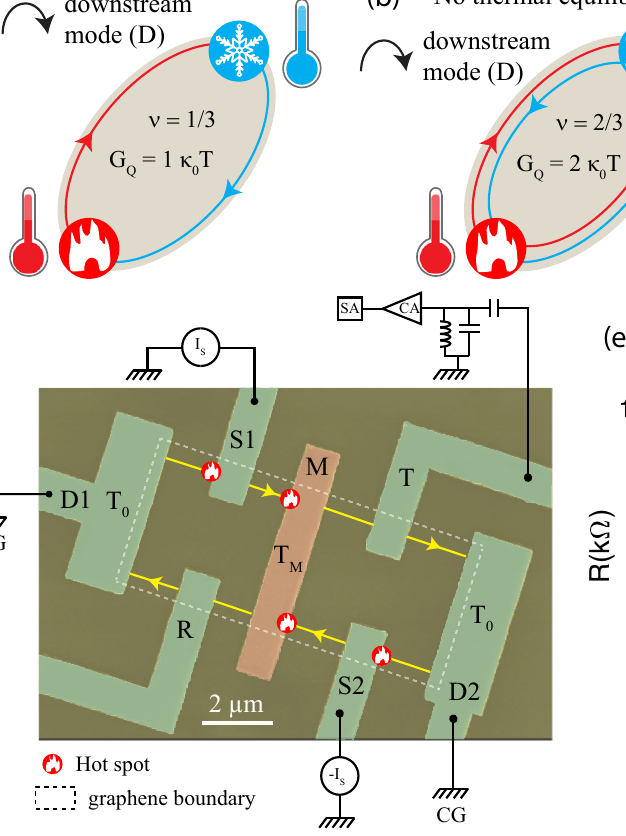
simultaneouslyatcontacts S 1and S 2.Duetothepowerdissipationnearthecentral, fl oating contact, the electron temperature increases to T M . The electrical and thermalconductancesaremeasuredrespectivelyatlowfrequency(23Hz)andhigh frequency(~740kHz)withanLCRresonantcircuit. e QHresponse:Theblacklineis the resistance R S 1 ( V S 1 / I S 1 ) measured at source contact ‘ S 1 ’ as a function of V BG at B=10Tandtemperature20 mK.Thebluelineshowsthemeasuredresistance( V R / ‘ R ’ . The green line shows the measured resistance ( V T / I S I S 1 ) at the contact 1 ) at the contact ‘ T ’ . The red curve shows the resistance V S 1 / I R measured at the contact ‘ S1 ’ , tance. Robustfractionalplateaus at 3 h e 2 , 5 h , 5 h , and 3 h areclearly visible.The legend 2 e 2 3 e 2 2 e 2 de fi nes the current sources and voltage probes for each curve. The subscripts of